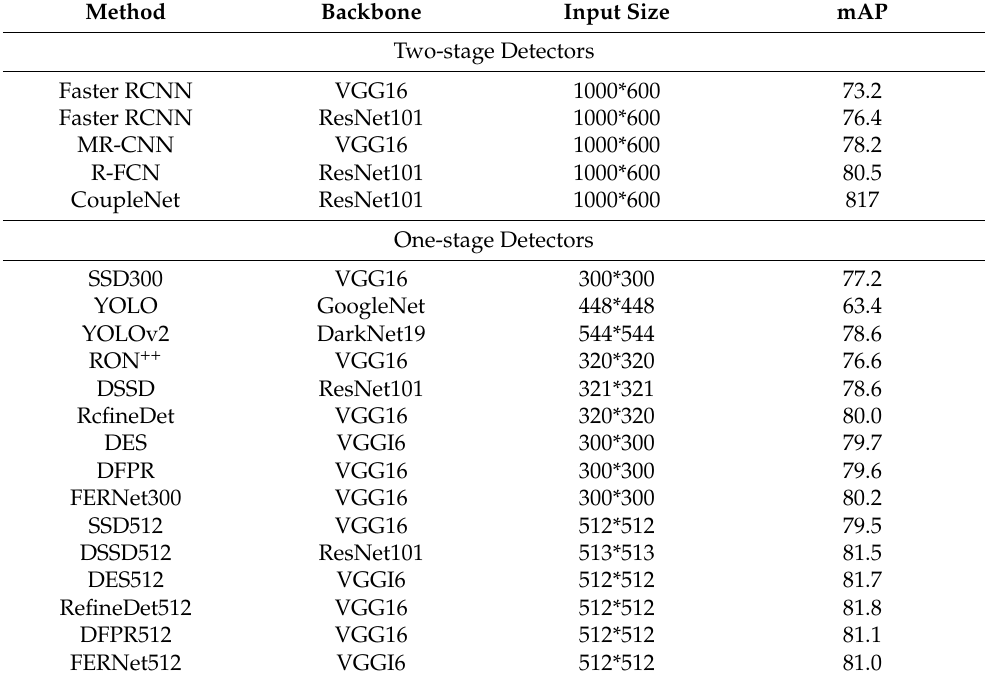
Table 1. Detection results of Labeled Fishes in the Wild dataset.